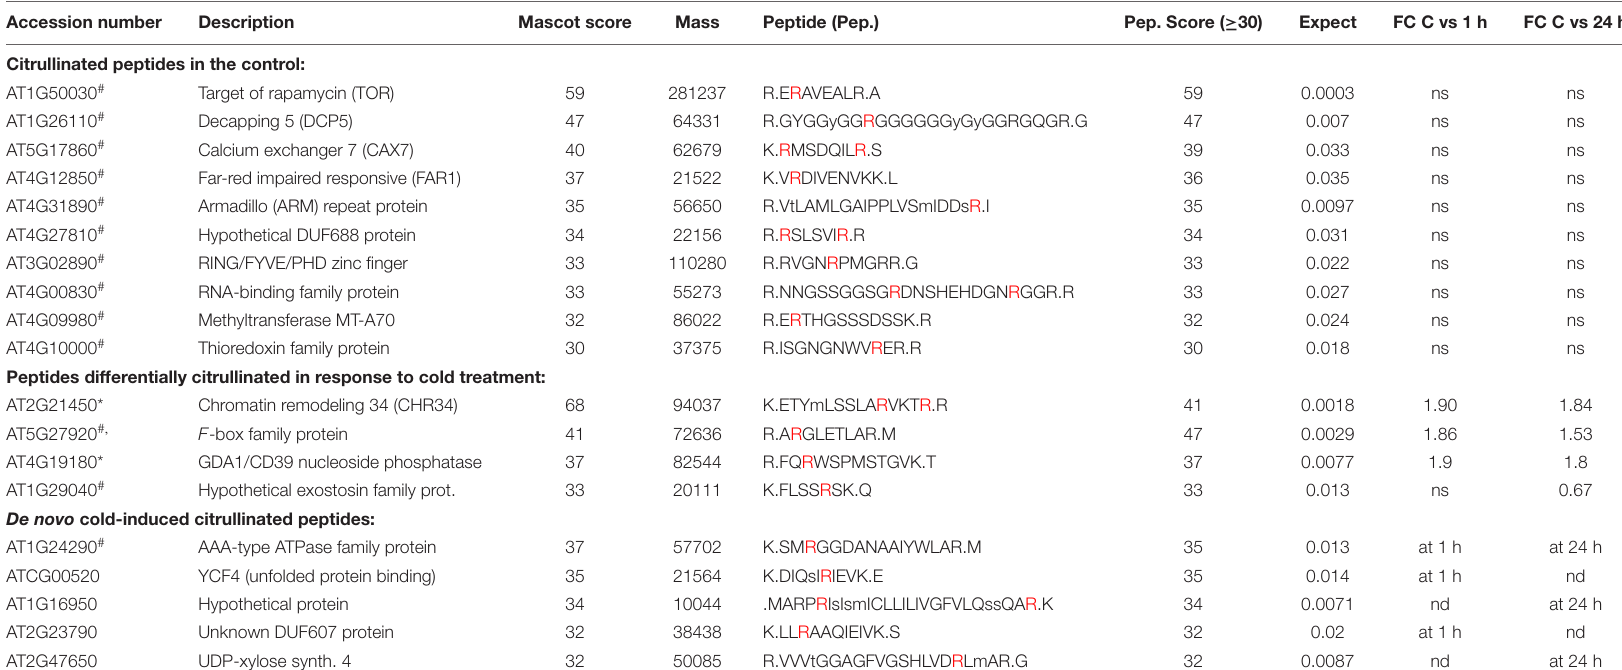
TABLE 1 | Citrullinated peptides and low-temperature stress induced citrullination events in Arabidopsis thaliana proteins.